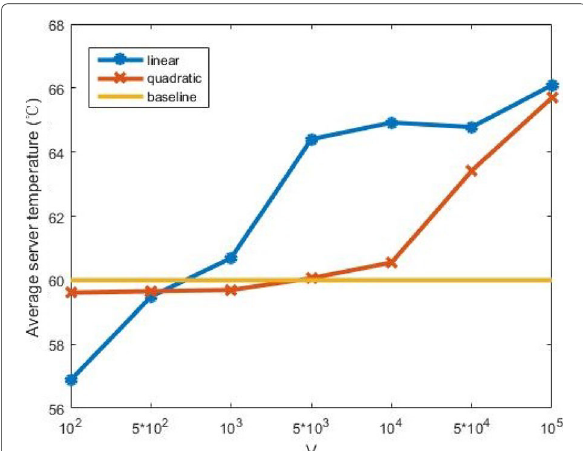
Fig. 13 Comparison in average number of active servers under different control vs. V